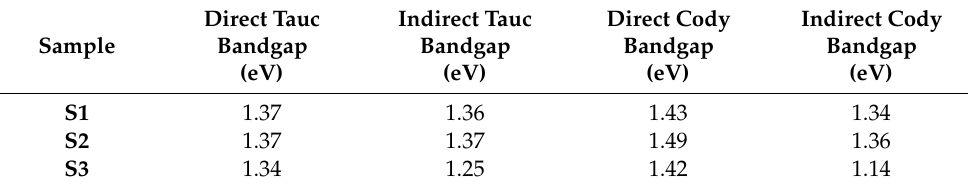
Table 2. Optic bandgap according Tauc and Cody